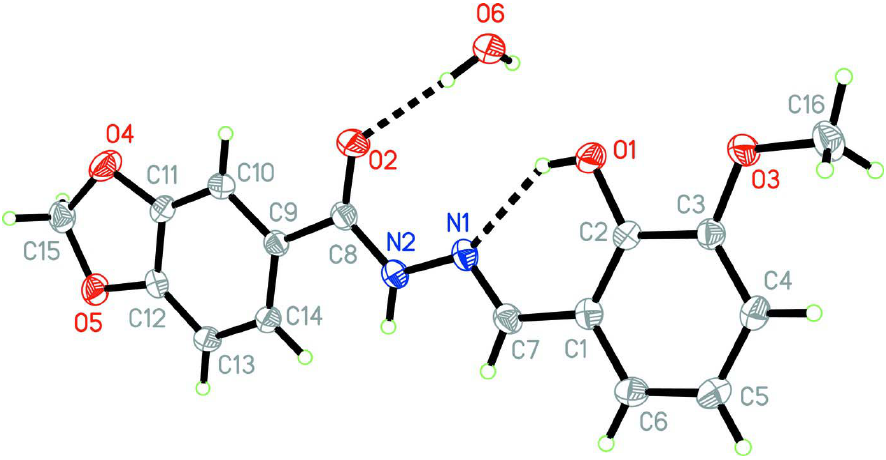
Figure 1 The structure of the title compound, showing 30% probability displacement ellipsoids and the atom-numbering scheme.